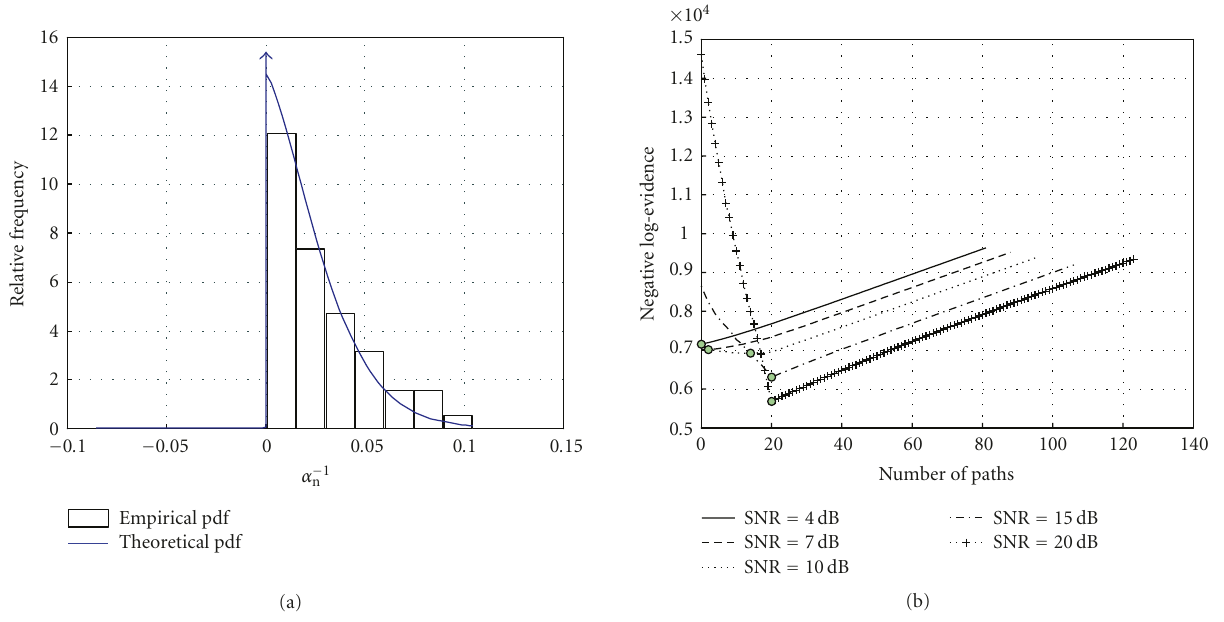
Figure 10: Evidence-based model selection criteria. (a) Empirical (bar plot) and theoretical (solid line) pdf’s of hyperparameters α − 1 10 dB, and P = 10). To compute the histogram N = 500 samples were used; (b) Negative log-evidence as a function of the model order (number of paths) for di ff erent SNR values ( P = 5, and L = 20).